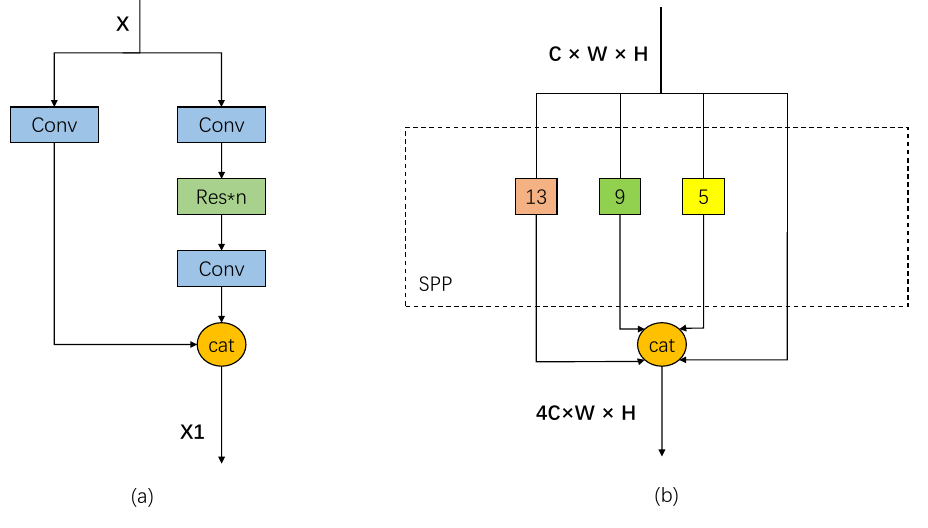
Figure 2. Structure of CSP and SPP. ( a ) CSP. ( b )